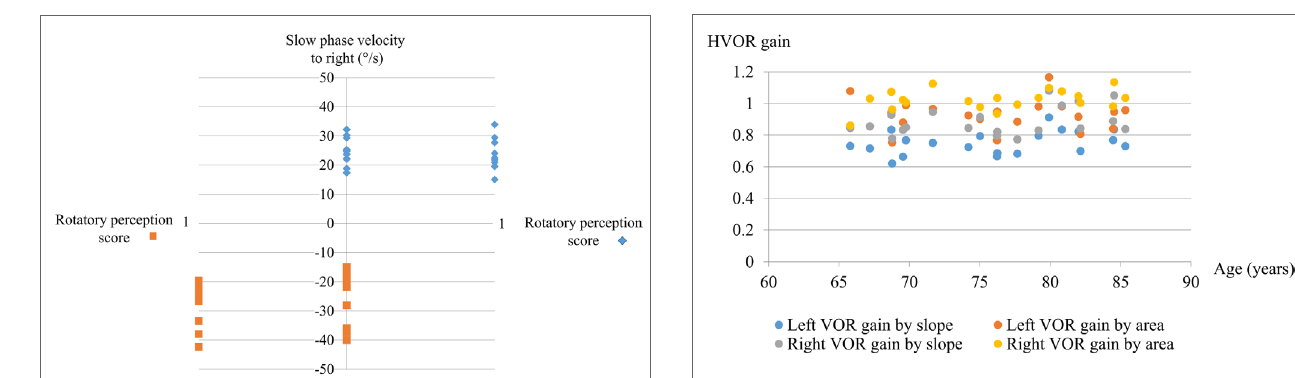
FigUre 3 | graph showing the gain of hVOr calculated by slope and area methods. There was no significant difference in HVOR gain with age between 65 and 86 years even for high accelerations (mean 3700 ± 550°/s 2 ). TaBle 3 | Mean values of amplitude and latencies for cVeMPs and oVeMPs for Pi senior and control senior groups in response to acs and BcV at Fz and mastoid.